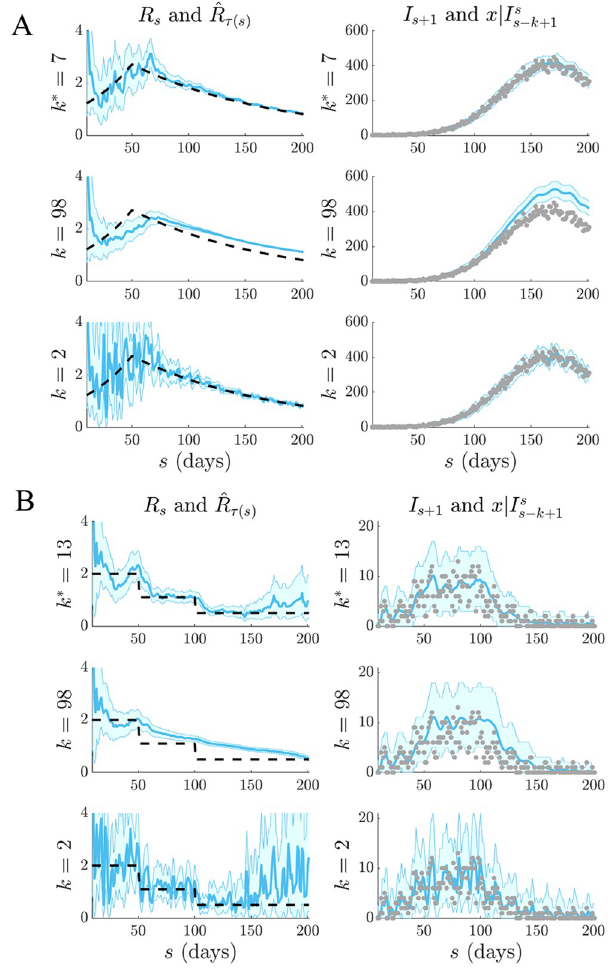
Fig 3. Selection for epidemics with interventions. Left graphs compare ^ R intervals) at the APE window length k � to those when k is set to its upper or lower limits. Right graphs give corresponding one-step-ahead predictions ^ I Dashed lines are the true R s numbers (left) and dots are the true I s counts (right). The panels examine (A) exponentially rising and decaying and (B) piecewise falling R